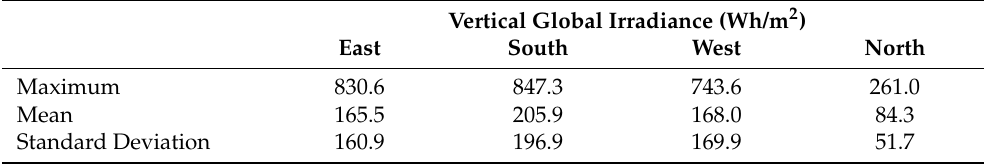
Table 3. Descriptive statistical summary of hourly global irradiance.